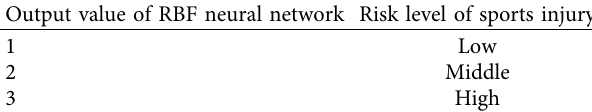
Table 3: Comparison table of RBF output and risk level assessment. Output value of RBF neural network Risk level of sports